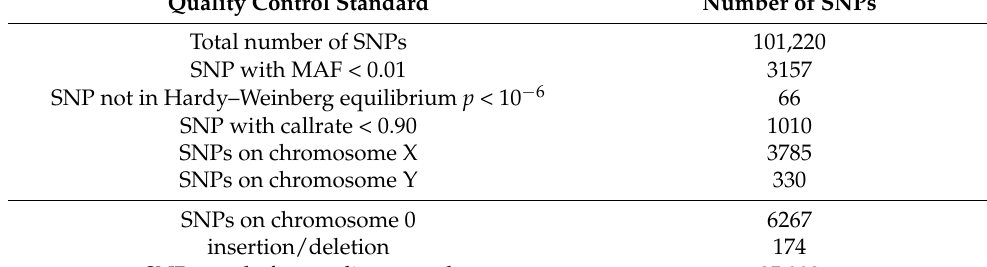
Table 1. Statistical Results of SNP Quality Control.